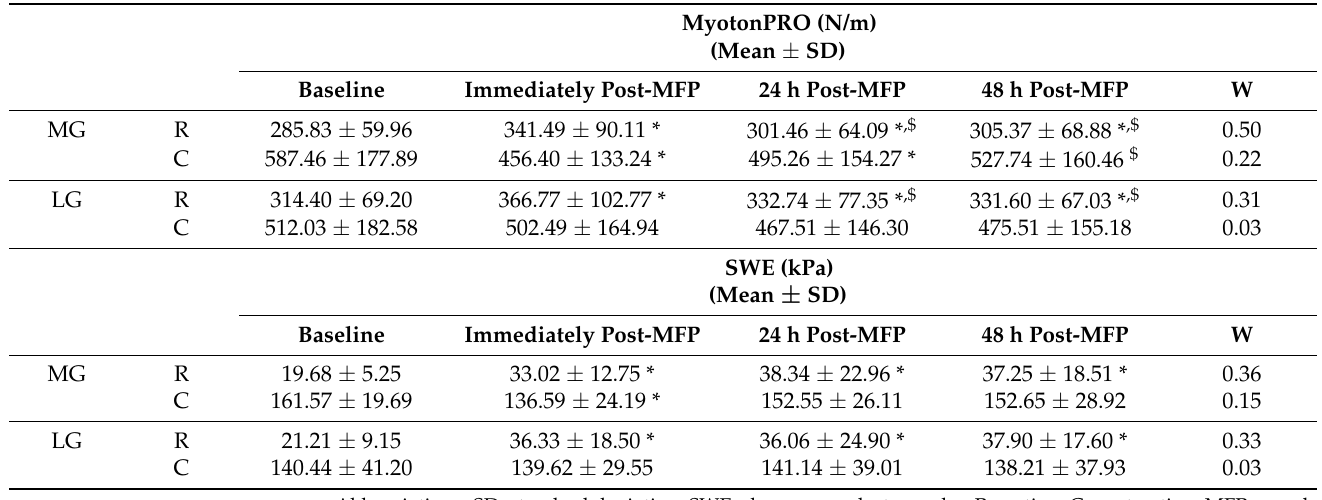
Table 2. Changes in muscle stiffness in the resting and contraction states across all measurement time points ( N =